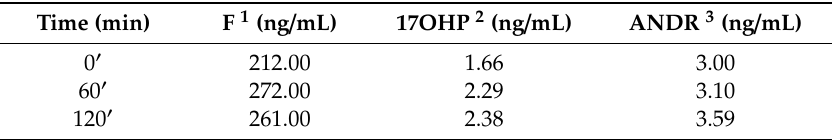
Table 3. Results of intravenous stimulation test with Synacthen.